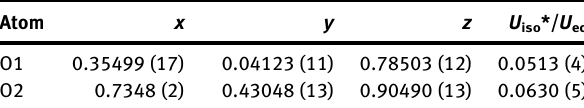
Table  : Fractional atomic coordinates and isotropic or equivalent isotropic displacement parameters (Å 